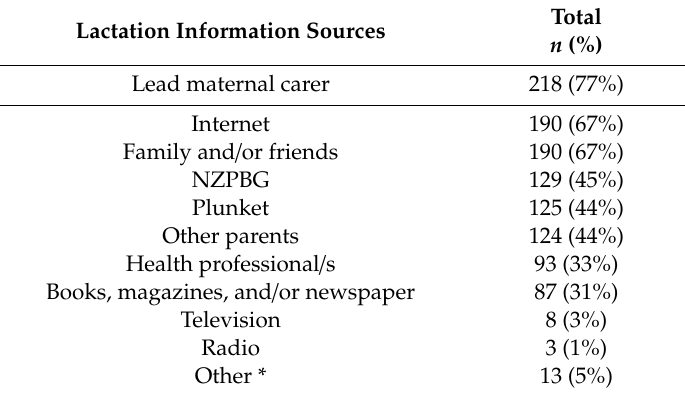
Table 9. Dietary information sources used during